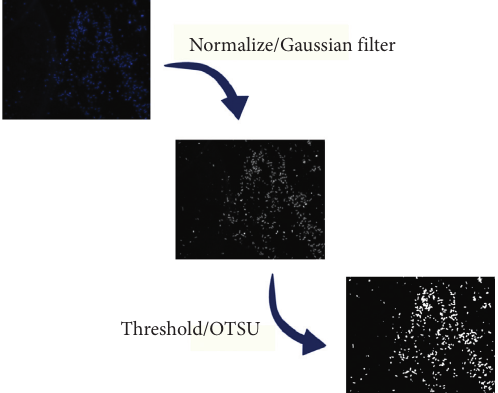
Figure 7: Image preprocessing to identify cell/area ratio.